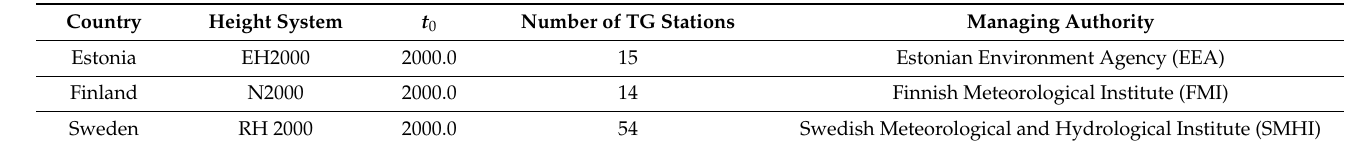
Table 1. National height systems, corresponding t 0 and the number of active TG stations (in 2021) managed by national TG authorities (cf. Figure